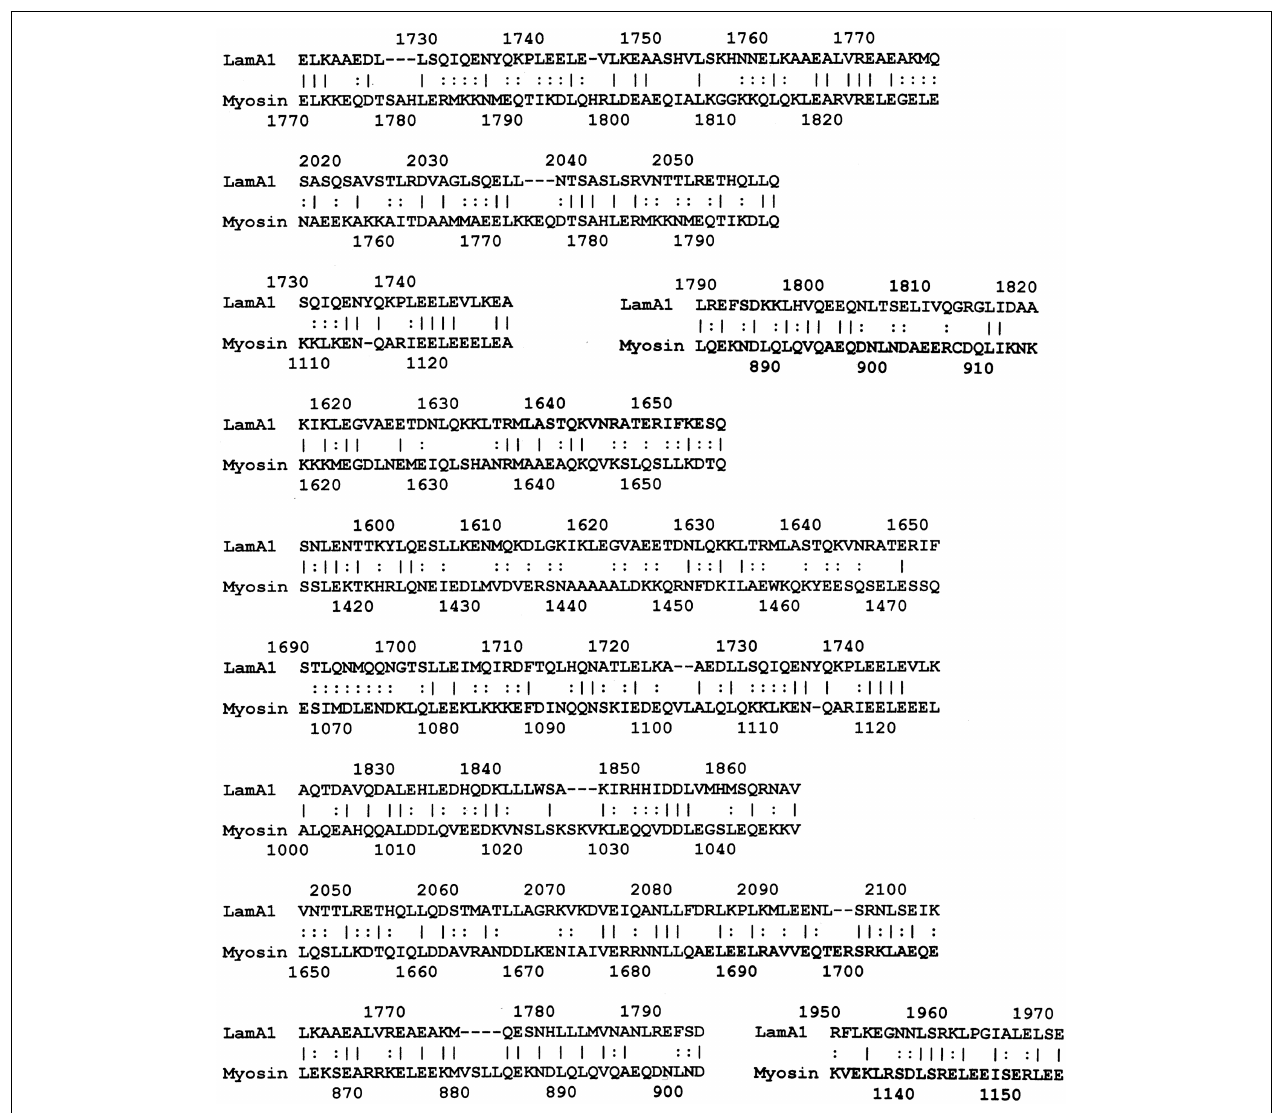
FIGURE 4 | Results of LALIGN similarity search comparing human laminin alpha 1 (P25391) to human cardiac myosin (P13533)